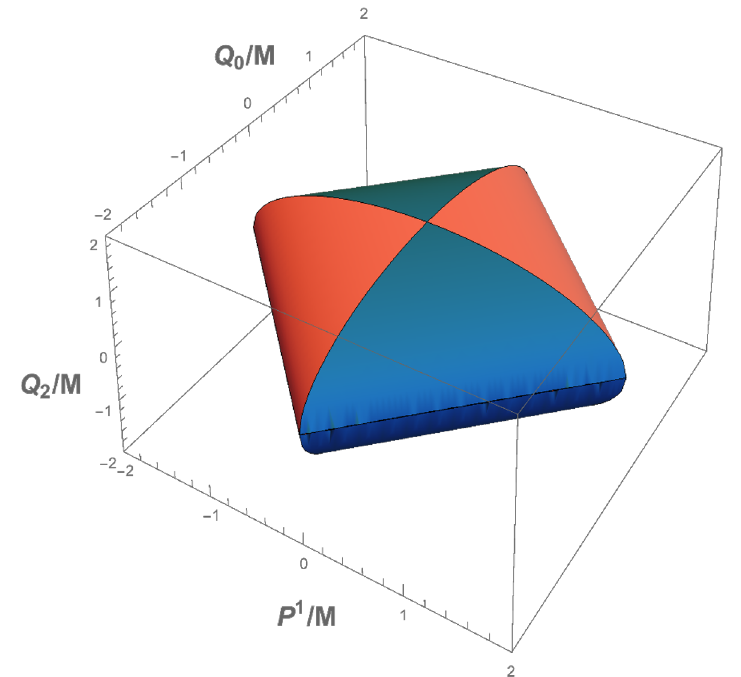
Figure 10. The extremal black hole region in an example of a compactification with h 2 , 1 = 2 , in the growth sector t (cid:29) s 2 . The blue regions correspond to extremal BPS black holes, while the red regions correspond to extremal non-BPS black